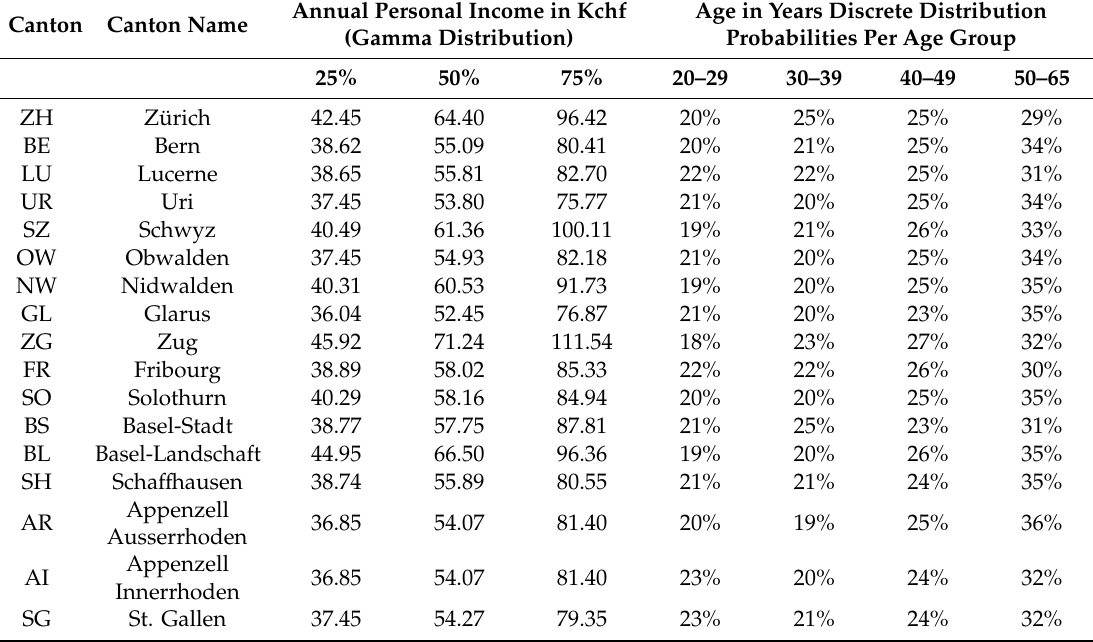
Table A5. Probability density functions of the random variables identifying an agent, per